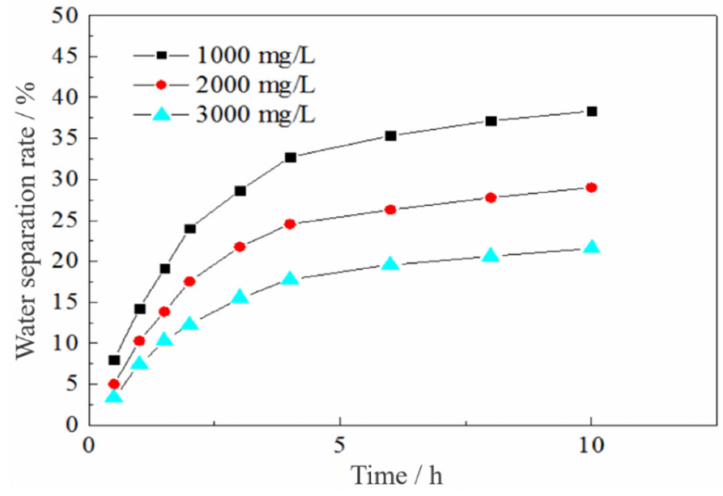
Figure 8. Relationship between the water separation rate and di ff erent concentrations.